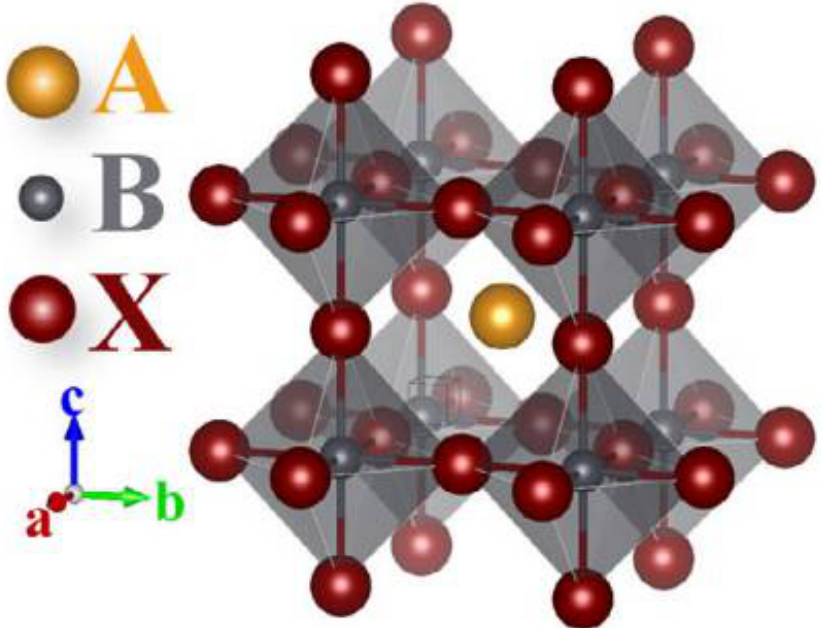
Figure 1. The structure of a typical perovskite crystal: the A ion is a monovalent cation, the B site is mainly composed of some divalent metal cations, and the X position is mainly composed of halide ions of halogen elements